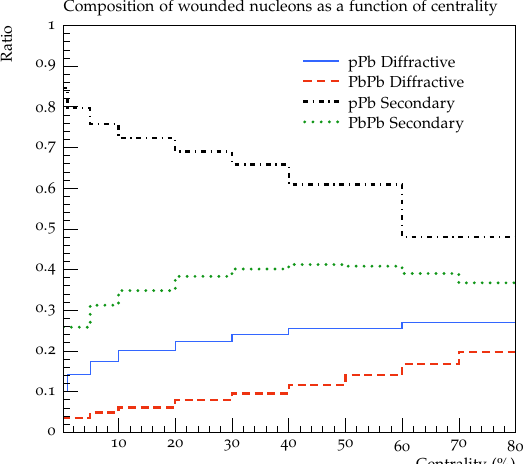
Figure 21 . The fraction of the wounded nucleons in the Angantyr model that are di(cid:11)ractively excited as a function of centrality for pPb at p s 2 : 76 TeV (red dashed line). Also shown is the fraction of wounded nucleons that come from secondary absorptive interactions in pPb (black dash-dotted line) and PbPb (green dotted